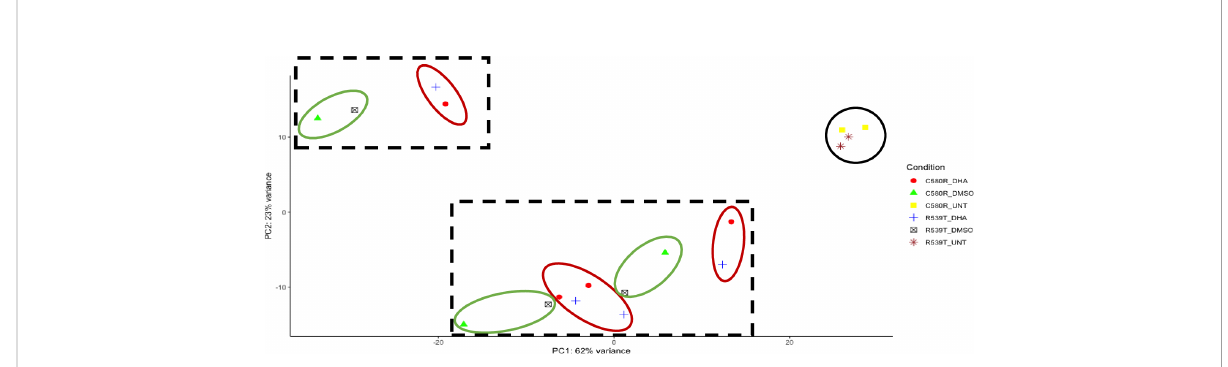
FIGURE 9 Principal component analysis (PCA) intimating at the transcriptional heterogeneity undergirding the ARTr phenotype. The dimensionality reducing technique PCA was used to explore the heterogeneity in gene expression pro fi le under DMSO and DHA treatment conditions for the two ARTr parasite lines (C580R and R539T) used in this study. The black circle shows the untreated ARTr samples. The black dashed squares outlines the two clusters of DMSO and DHA-treated samples. In each square, the red circles show the different clusters for the C580R, and R539T DHA treated samples, and the green circles show the different clusters for the C580R and R539T DMSO treated samples.